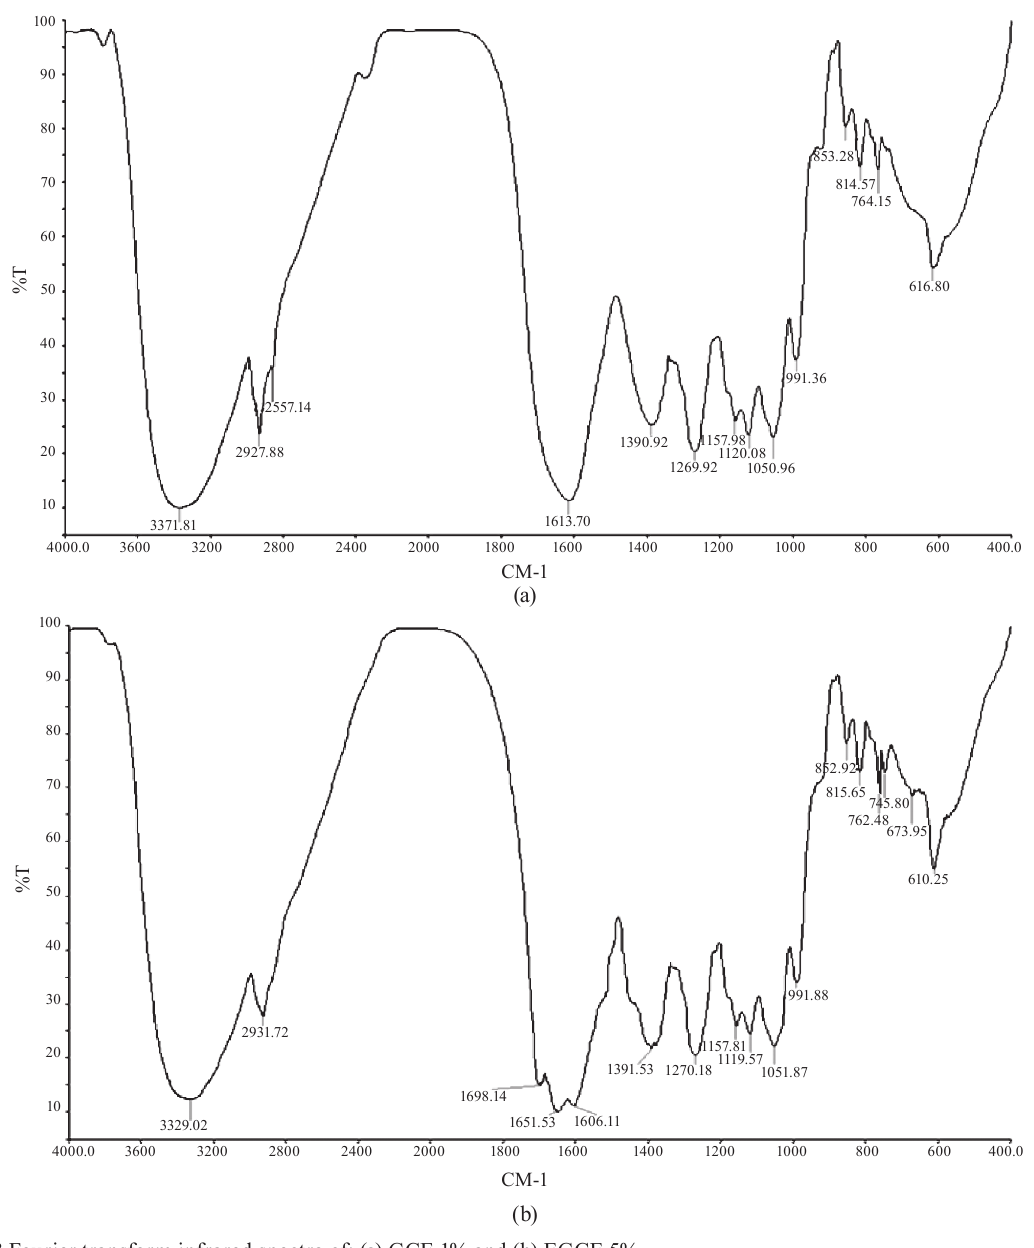
Figure 3 Fourier transform infrared spectra of: (a) GCE 1% and (b) EGCE